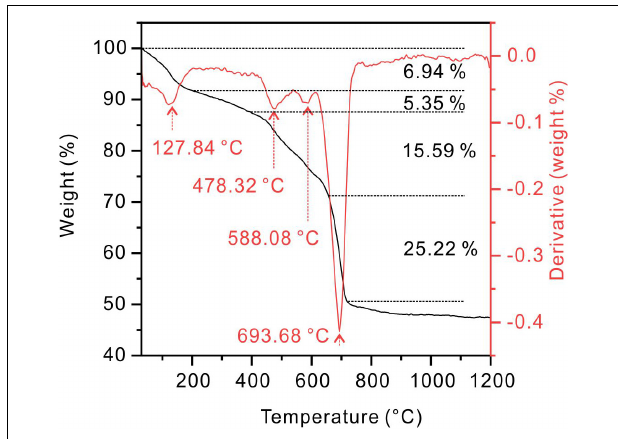
FIGURE 10 | Thermogravimetry and differential scanning calorimetry (TG-DTG) curves of protodolomite induced by Vibrio harveyi QPL2 in a medium with a Mg/Ca molar ratio of